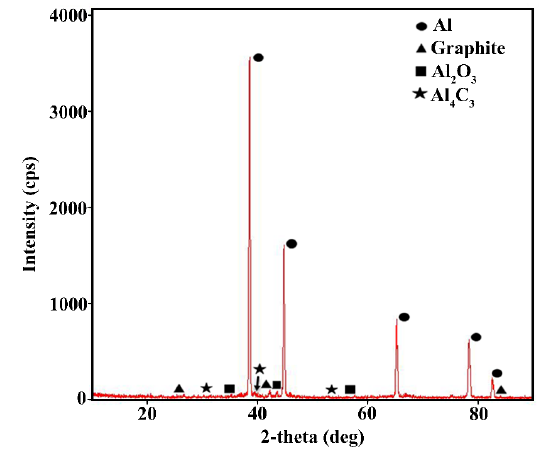
Figure 3: Changes in hardness and density of composite materials with different amounts of Al 2 O 3